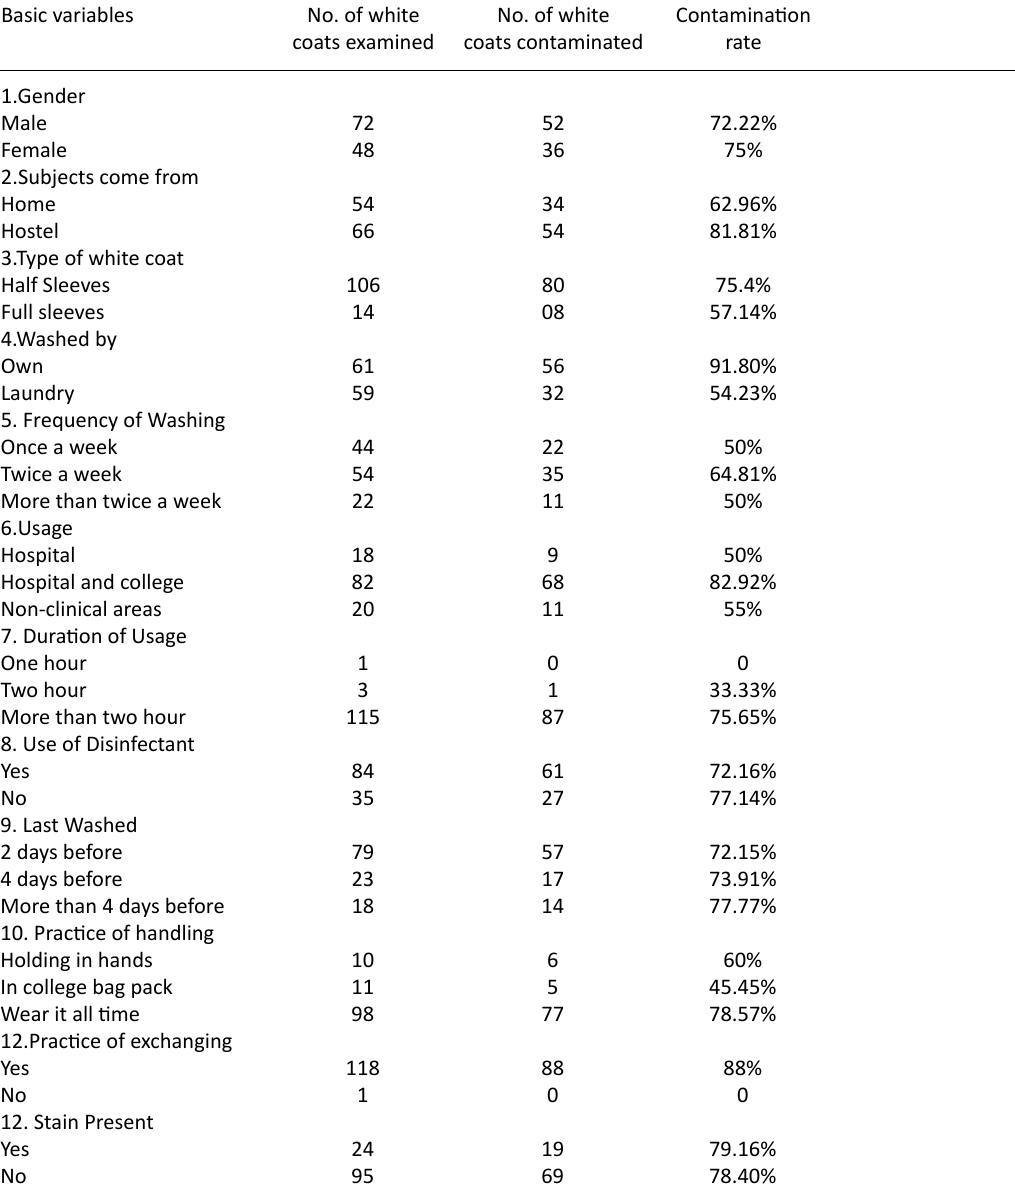
Table 6. Questionnaire Distribution (N=120) Basic